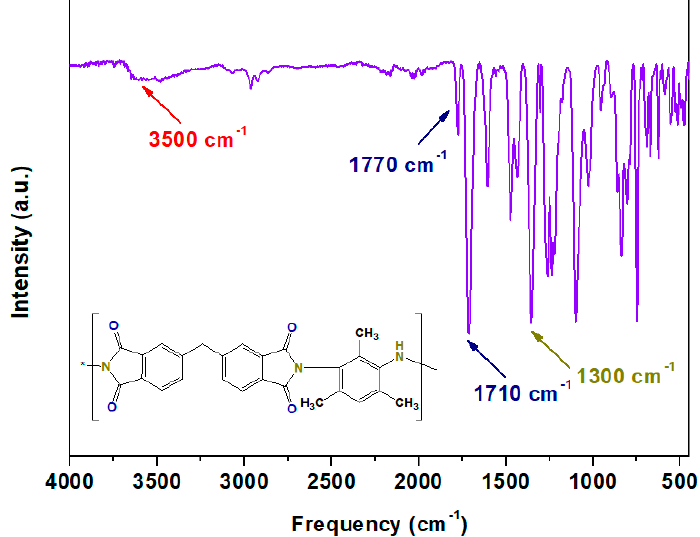
Figure 6. FTIR spectrum of ODPA-TMPDA polymer.